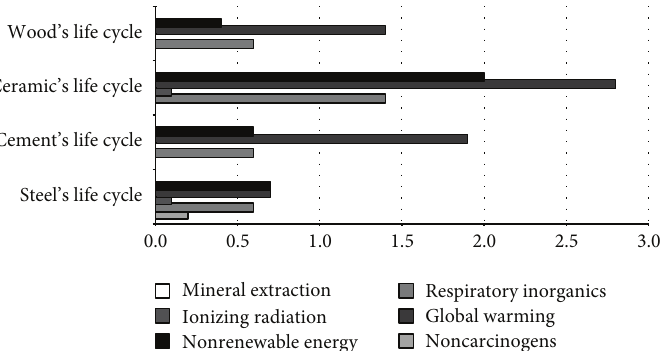
Figure 6: Comparison of the life cycles of selected materials, IMPACT2002+ method, and single score